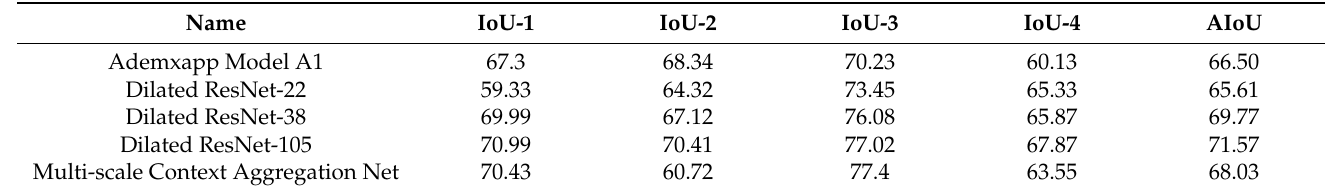
Table 3. AIoU comparison by different CNNs for green area